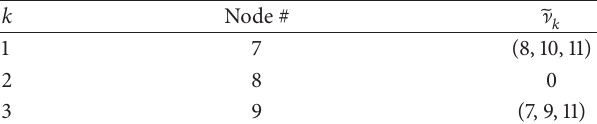
Table 2: The available times of the three service locations.